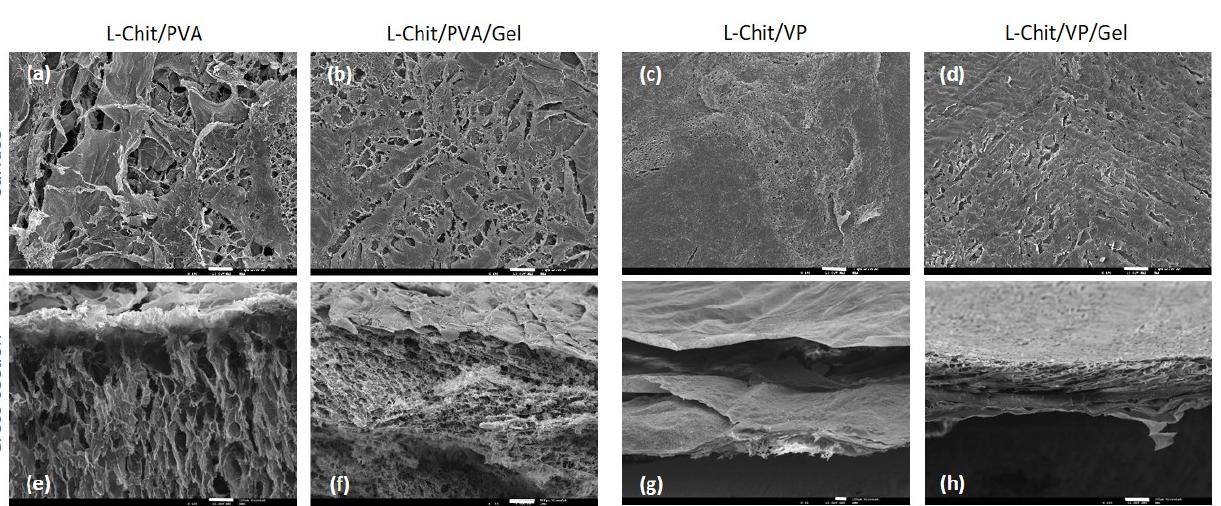
Figure 5. Swelling degree in distilled water of low-Mw chitosan-based membranes γ -irradiated at 10 kGy expressed as mean ± SD ( n = 3); n.d.: not determined. From Figure 5, it is clear that chitosan-based membranes without gelatin in their composition are the ones that presented the highest swelling degree values. On the other hand, membranes that also incorporate gelatin presented lower swelling values. Particularly, in the case of L-Chit/VP/Gel, membranes turned into a swollen transparent soft matter close to soluble, making it impossible to handle and weight the sample. For that membrane, it was not possible to determine membranes’ swelling degree. The reason for that could be related to gelatin itself, which is a mixture of water-soluble proteins. In this way, the solubilization of gelatin would lead to samples’ weight loss and consequent lower swollen weight. Additionally, these results also seem to indicate that the extension of gelatin radiation degradation was most likely higher than the eventual radiation- induced crosslinking between the other membranes’ components and the gelatin. Additionally, contrary to what macroscopic observation suggested, the L-Chit/VP membrane, which was the one with the lowest volume increase, was the one which presented the highest swelling degree. n.d.